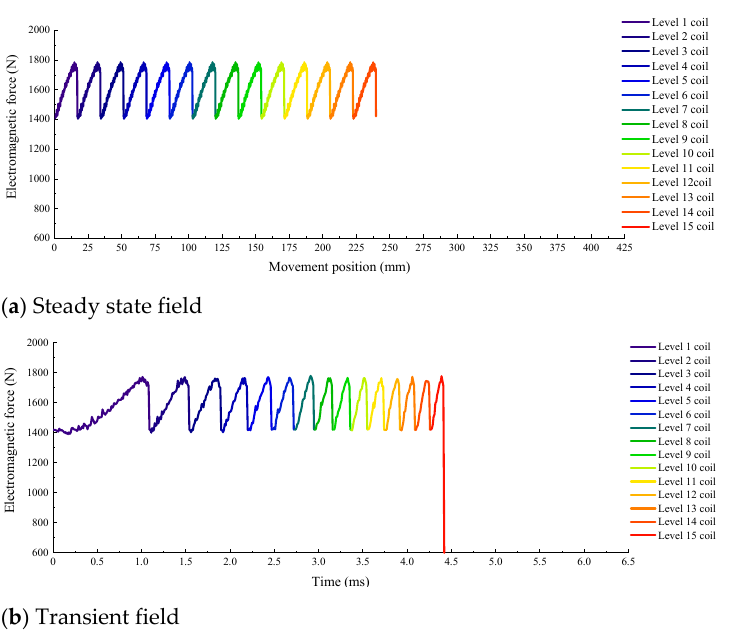
Figure 13. The electromagnetic force of 15 mm continuous acceleration coil.